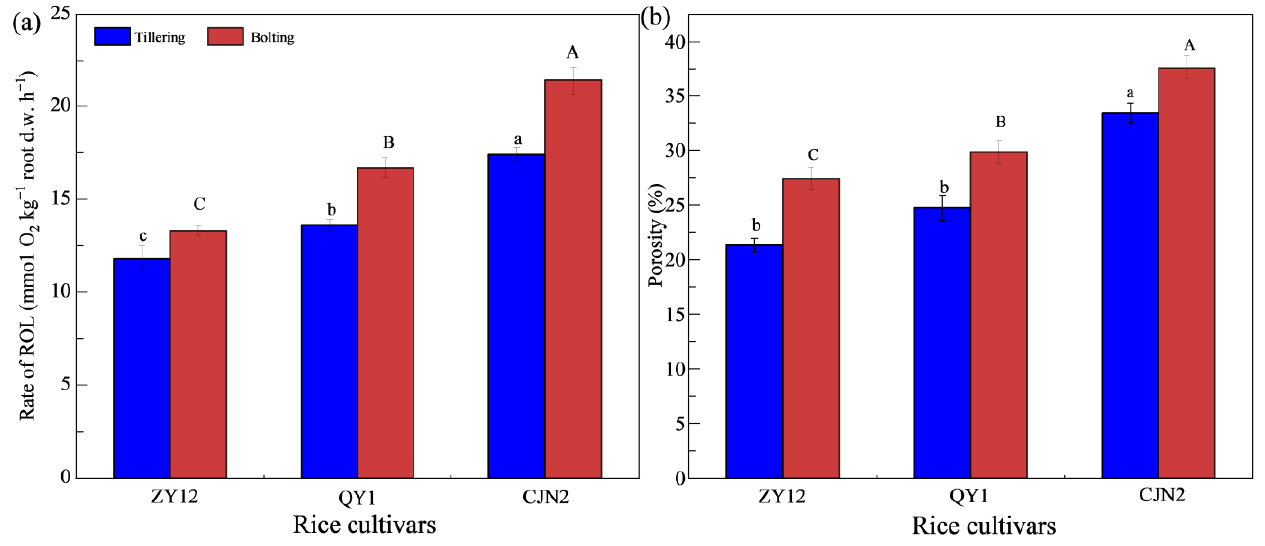
Figure 1. Radial-oxygen-loss rates (ROL) ( a ), and root porosity ( b ) of rice. Data are the mean ± SE ( n = 3). Different upper- and lowercase letters above bars indicate significant differences among the cultivars at the tillering and bolting stages, respectively.